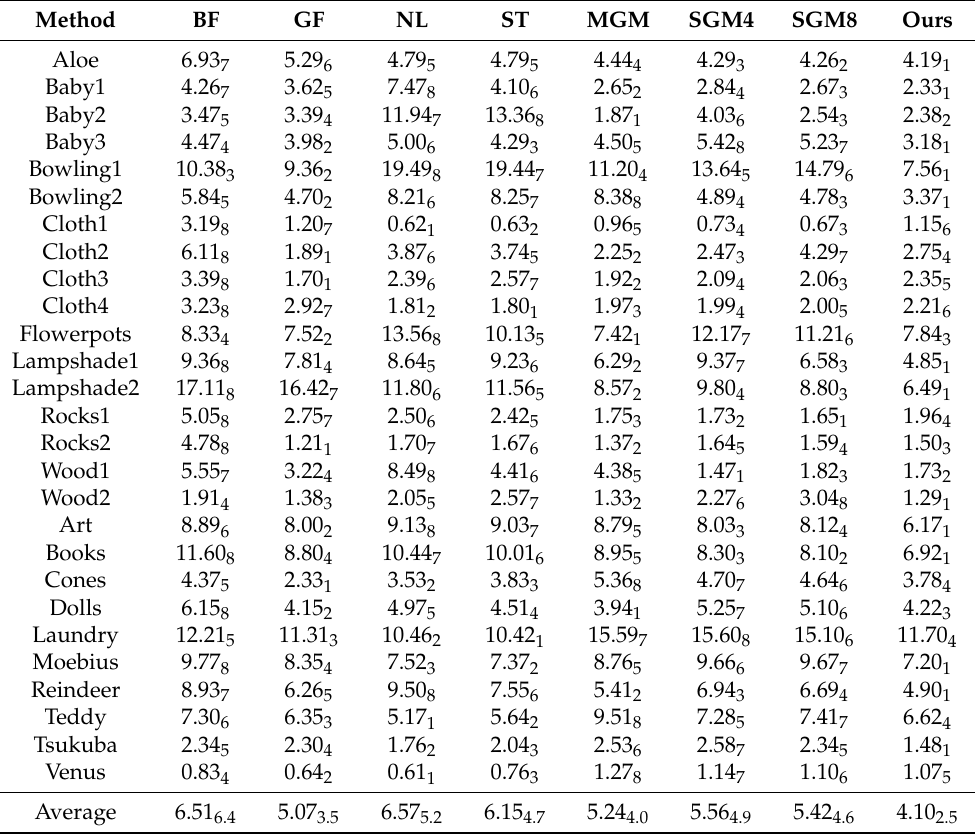
Table 2. Percentages of error pixel (/%) in non-occluded region and corresponding rankings for typical cost aggregation methods on Middlebury dataset [9].